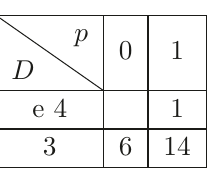
Table 13 . The F 8 , 6 family of branes for the ( T 4 / Z 2 ) × T n